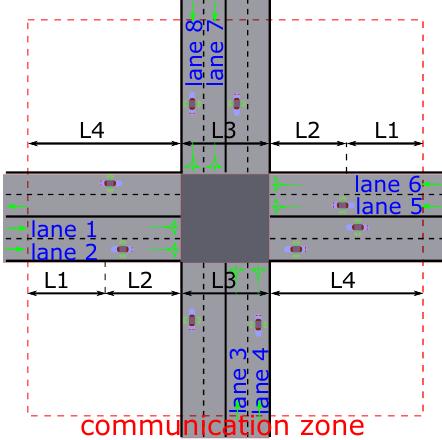
Figure 1. Isolated intersection